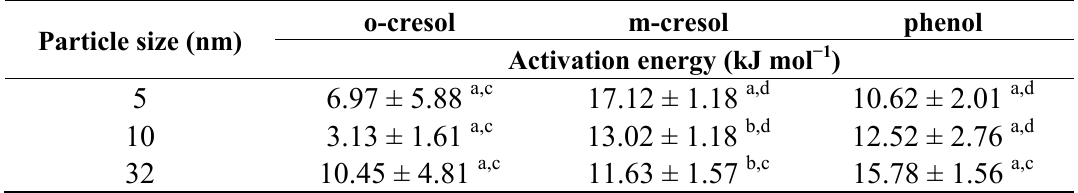
particle sizes. 2